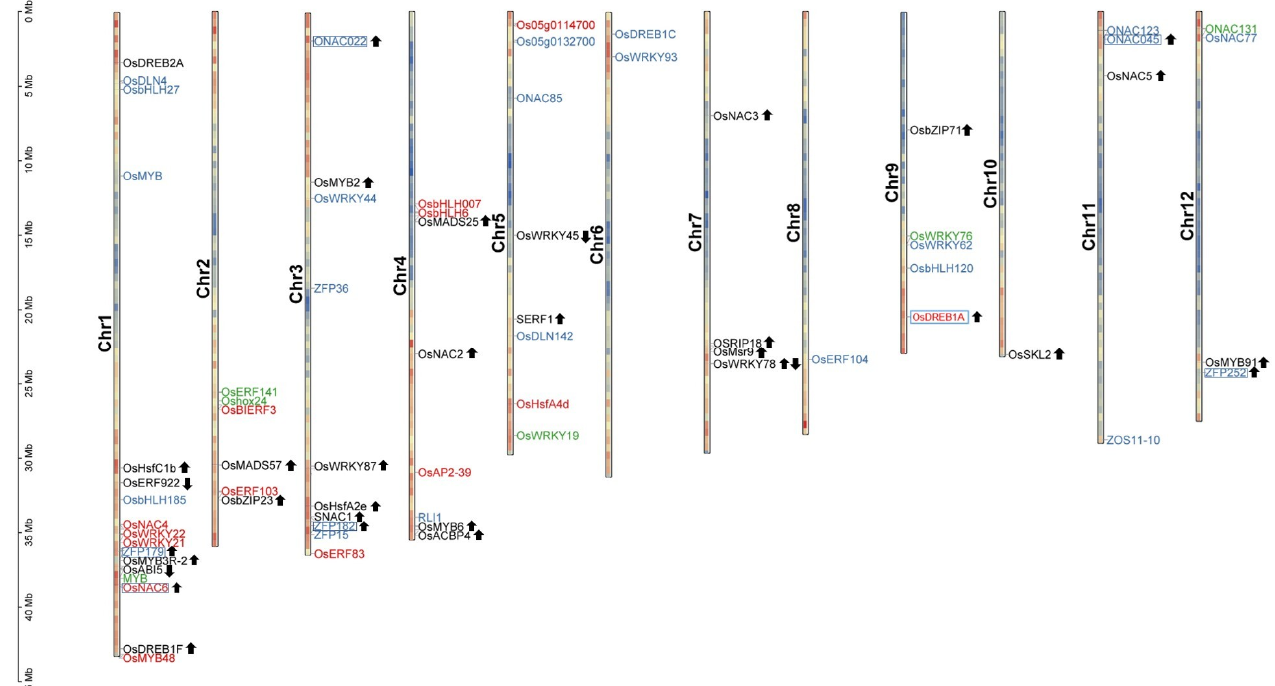
Figure 5. Physical locations of previously identified TFs which contributed to NaCl tolerance and the TF candidate genes in the current study. The twelve rice chromosomes are represented by color bars, and the physical positions of the TF genes correspond to the scale on the left. The gene names in black were identified by previous studies, the gene names in blue represent co-expressed DE-TFs of diploid and tetraploid plants under three stress conditions, the gene names in red represent uniquely expressed DE-TFs of tetraploid plants under three stress conditions, and the gene names in green represent uniquely expressed DE-TFs of diploid plants under three stress conditions. The genes in blue boxes have been identified to be associated with salt tolerance. Black arrows: up indicates positive regulation; down indicates negative regulation.